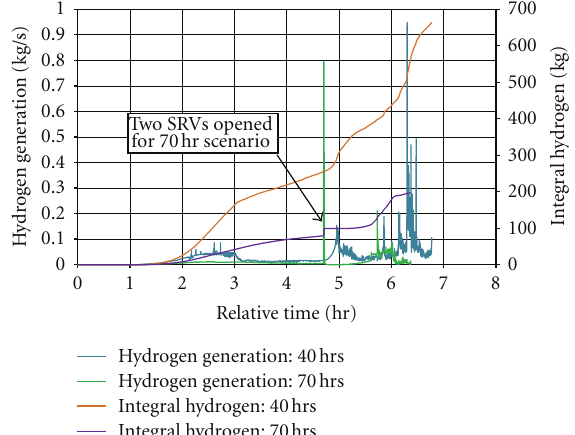
Figure 29: Hydrogen generation rate and integral hydrogen for the two scenarios with initial loss of the emergency water injection at 40 hours and 70